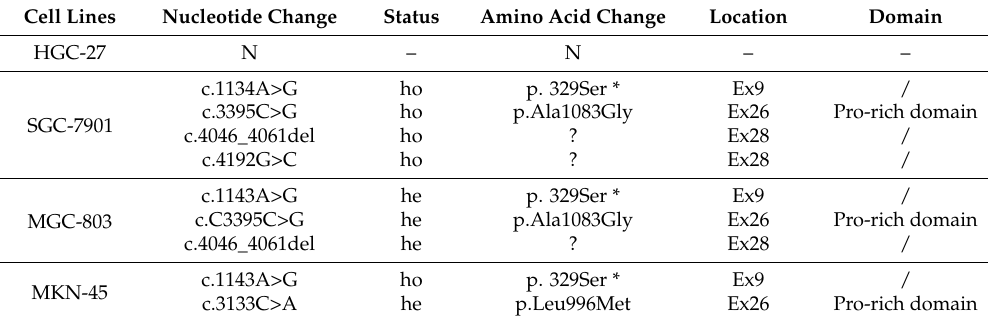
Table 1. SHIP2 mutations in gastric cancer lines.